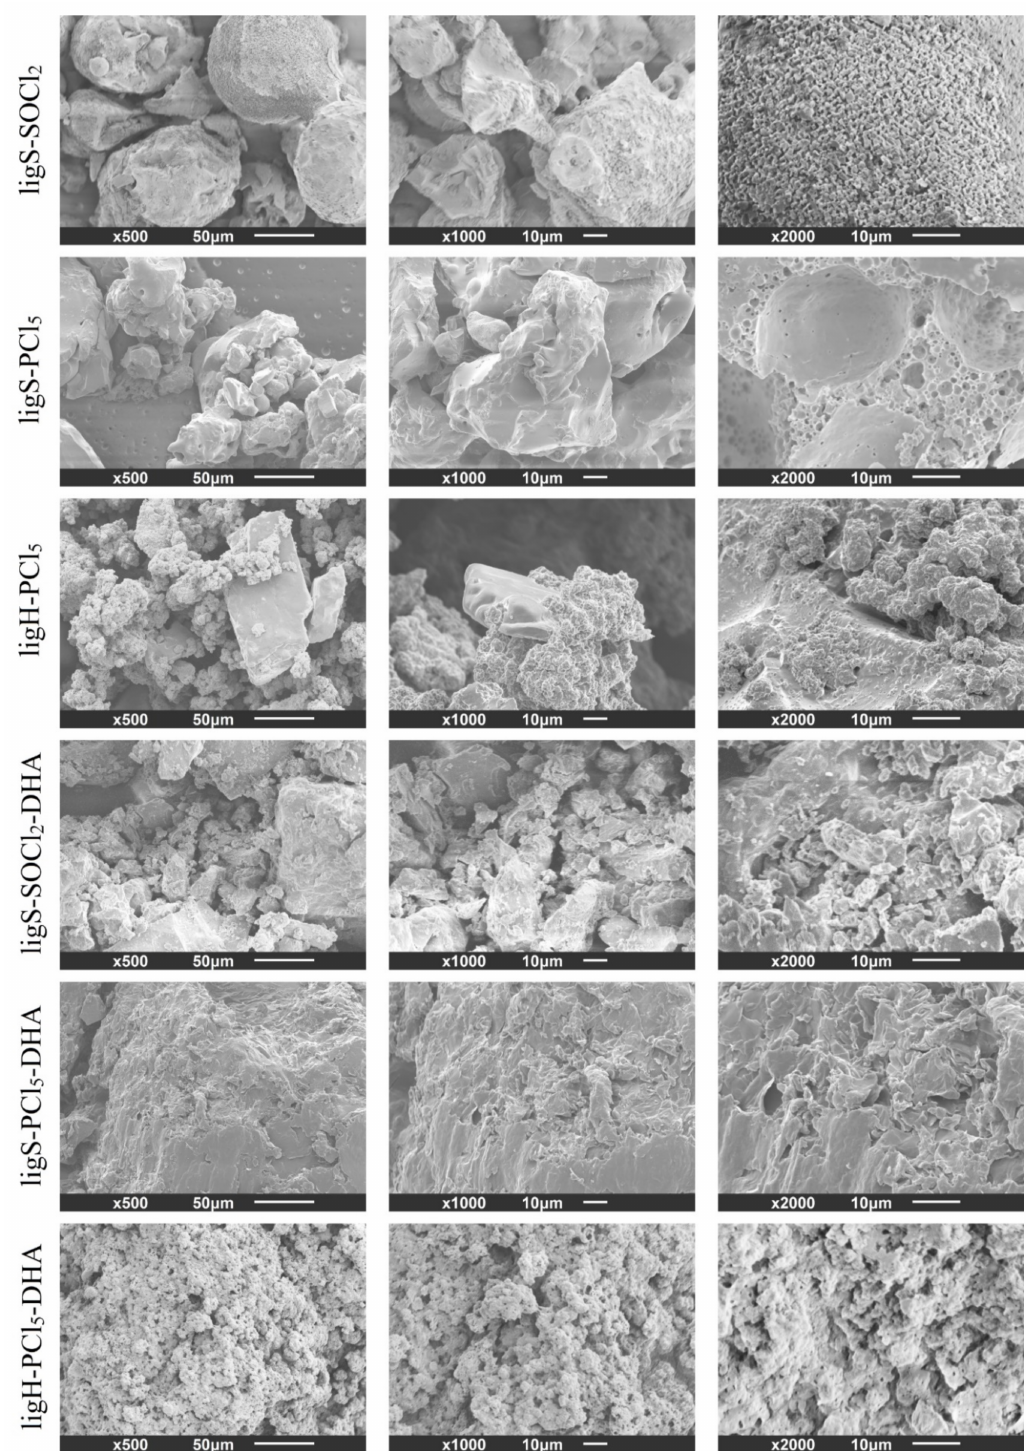
Figure 6. Morphology of lignin derivatives obtained after each step of the modification